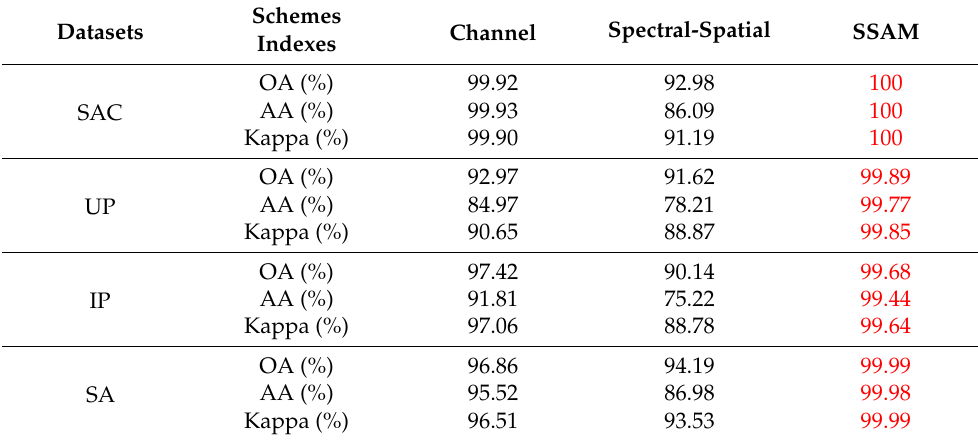
Table 9. Effectiveness analysis of SSAM on the four experimental datasets.